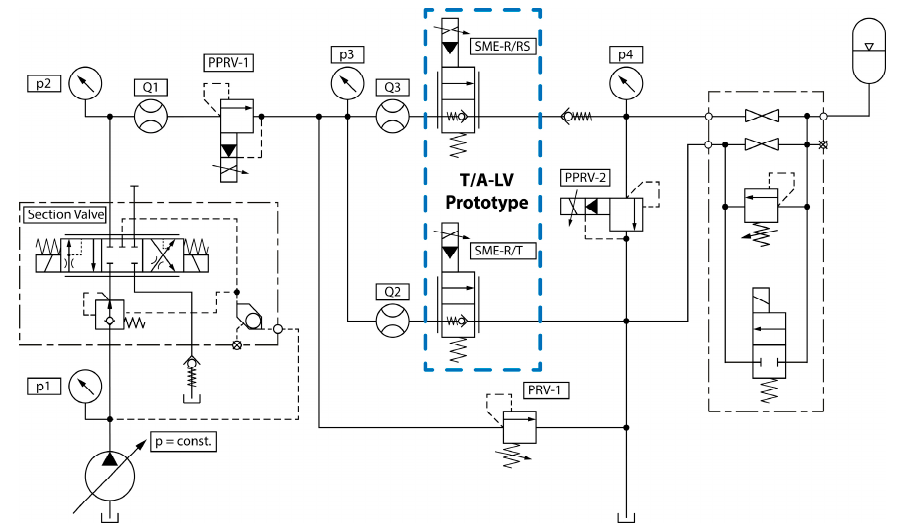
Figure 11. Test Rig T/A-LV. Previously reported in [17]. Reproduced with permission from the publisher. Figure 12 shows the smoothed result of the verification experiment. In the upper part of the diagram, the measured system pressure p1 (CPS, blue dashed line, ), the measured section pressure p2 (black line, ), the signal of the nominal load pressure (green line, ), the return line pressure p3 (red dash-dotted line, ) and the predicted section pressure (orange dash-double-dotted line, ) can be seen. Figure 12 (bottom) shows the measured flow rate Q1 (black line, ) and the predicted flow rate (orange dash-double-dotted line, ). In the diagram, predicted trajectories show what the measured trajectories of the corresponding values were expected to look like. From the beginning of the measurement until 9.5 s, the section load pressure is increased by the pressure level of the RS (approx. 60 bar), meaning that even with the load applied by PPRV-1, valve SME-R/T is closed and the entire flow rate runs through the RS.